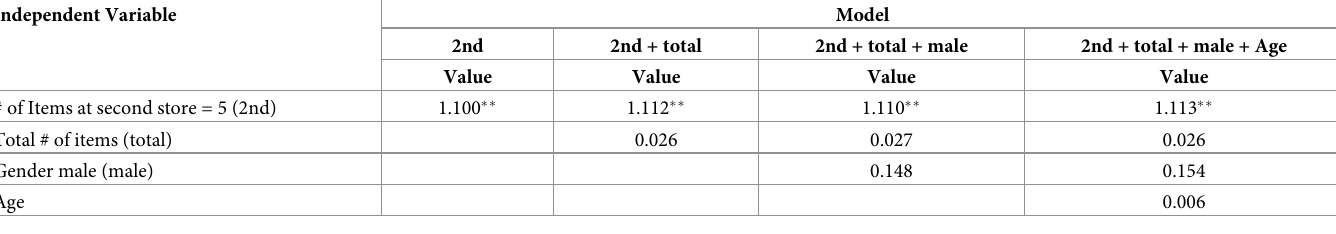
Table 10. Ordered logistic results against likelihood (n =